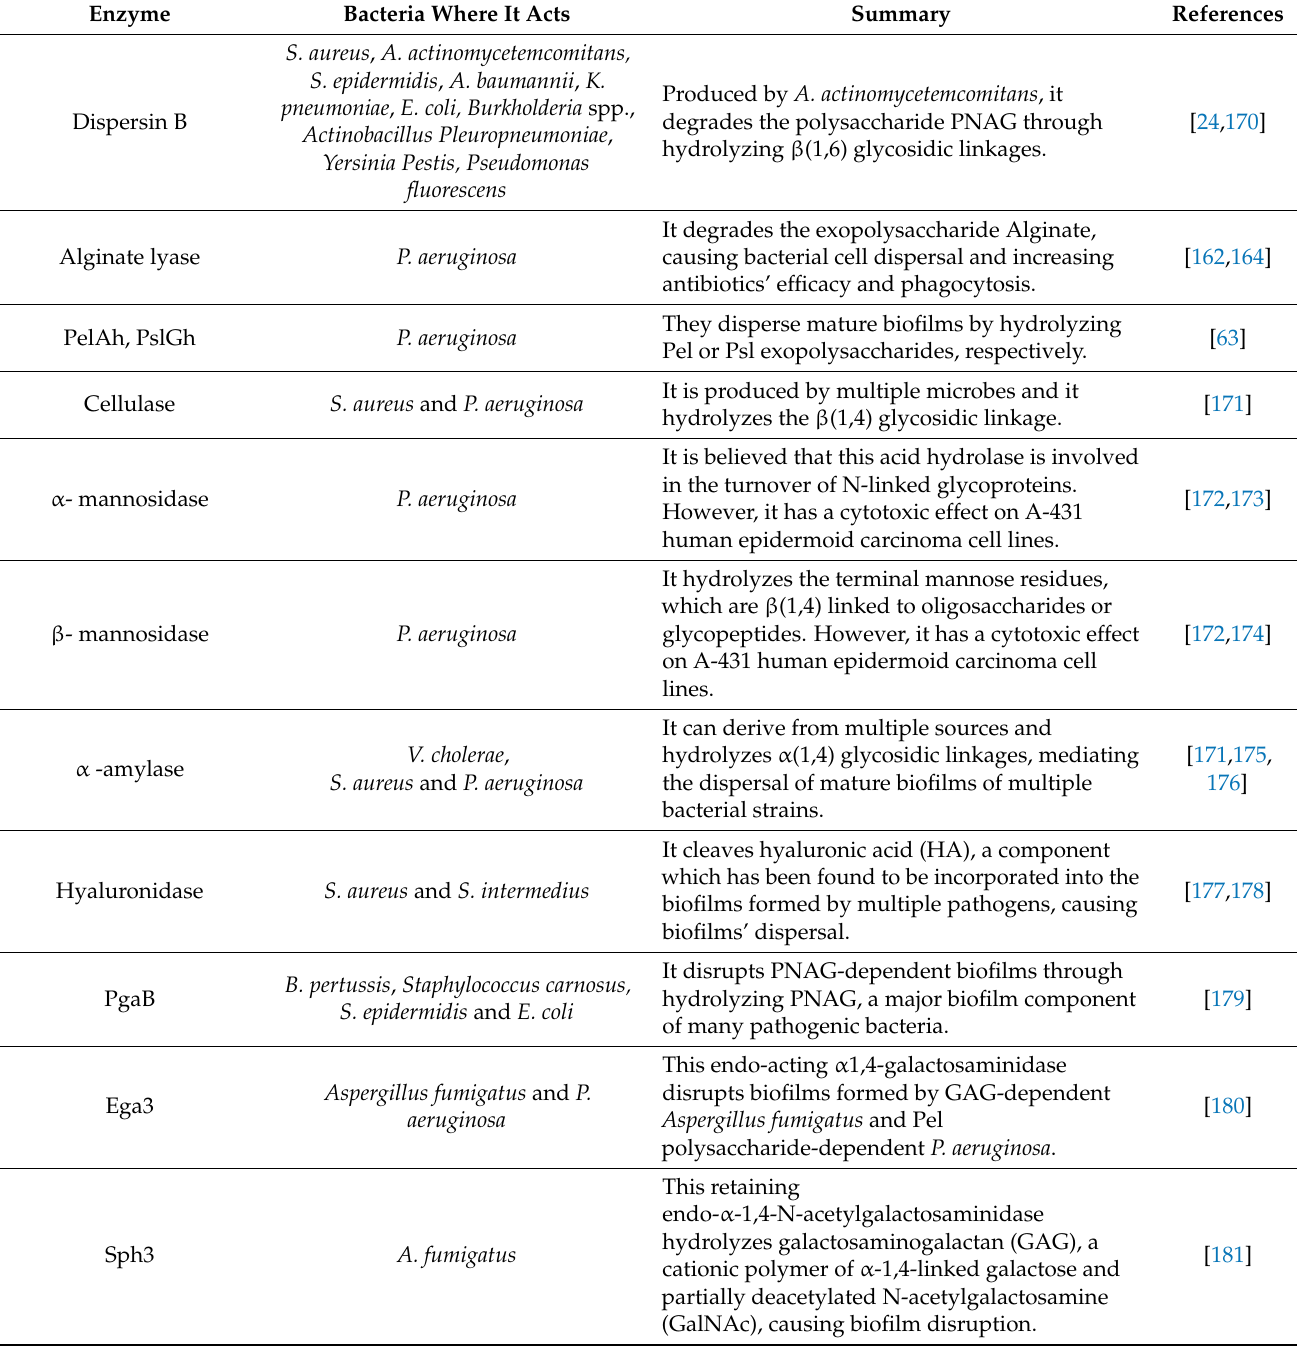
Table 3. Glycoside hydrolases that disperse biofilms. Adapted with permission from